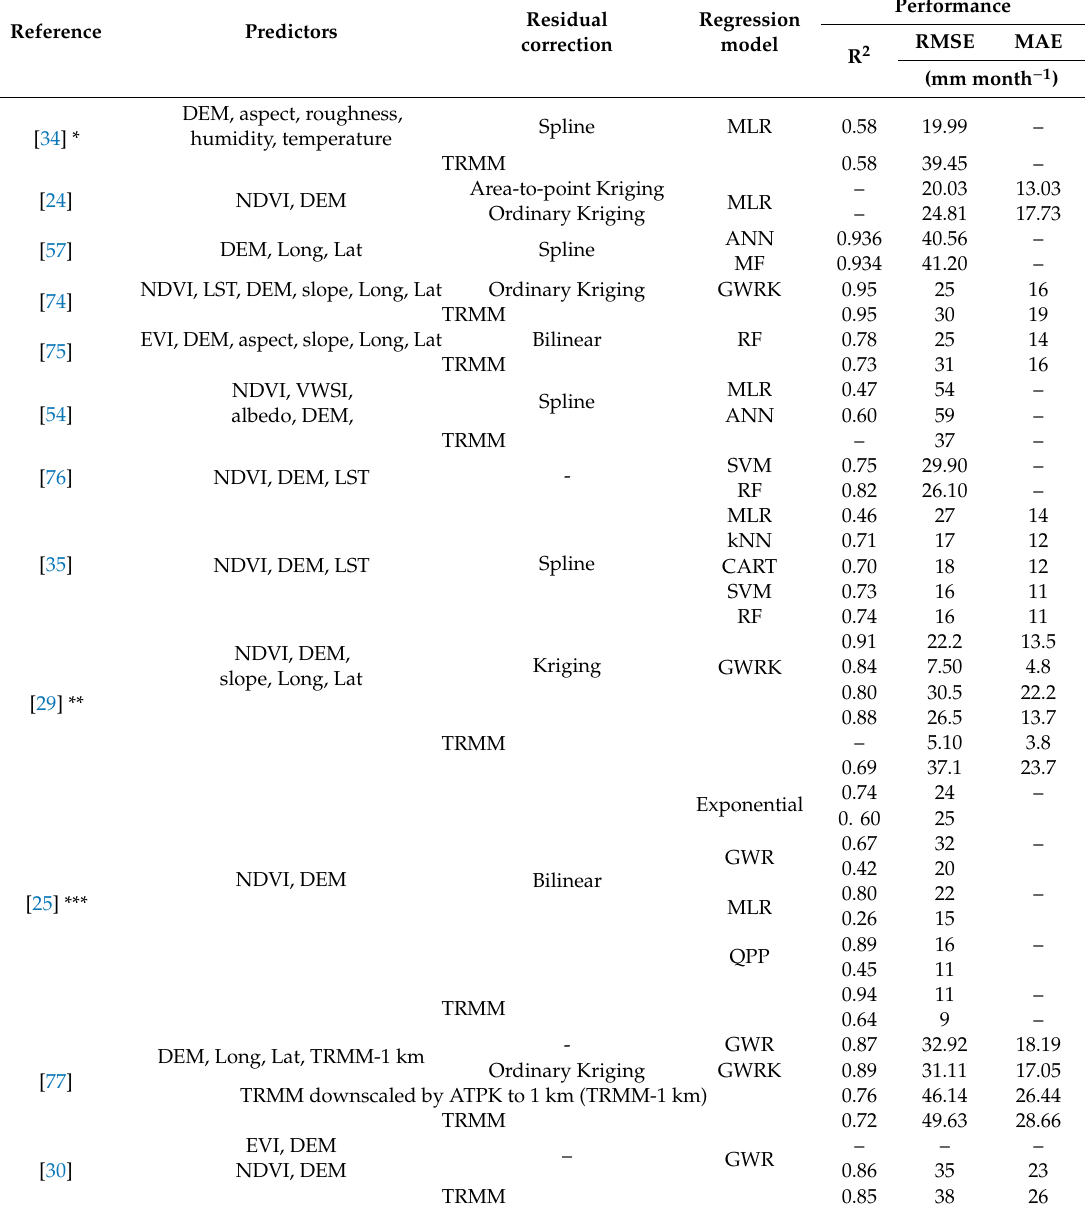
Table A1. Summary of relevant studies for monthly downscaling TRMM precipitation